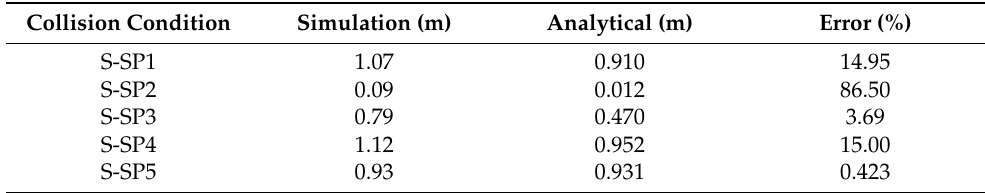
Table 11. The simulation results and analytical results of the penetration depth. Collision